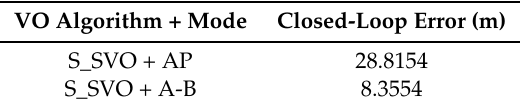
Table 7. Experiment 2: The closed-loop error on dataset2.